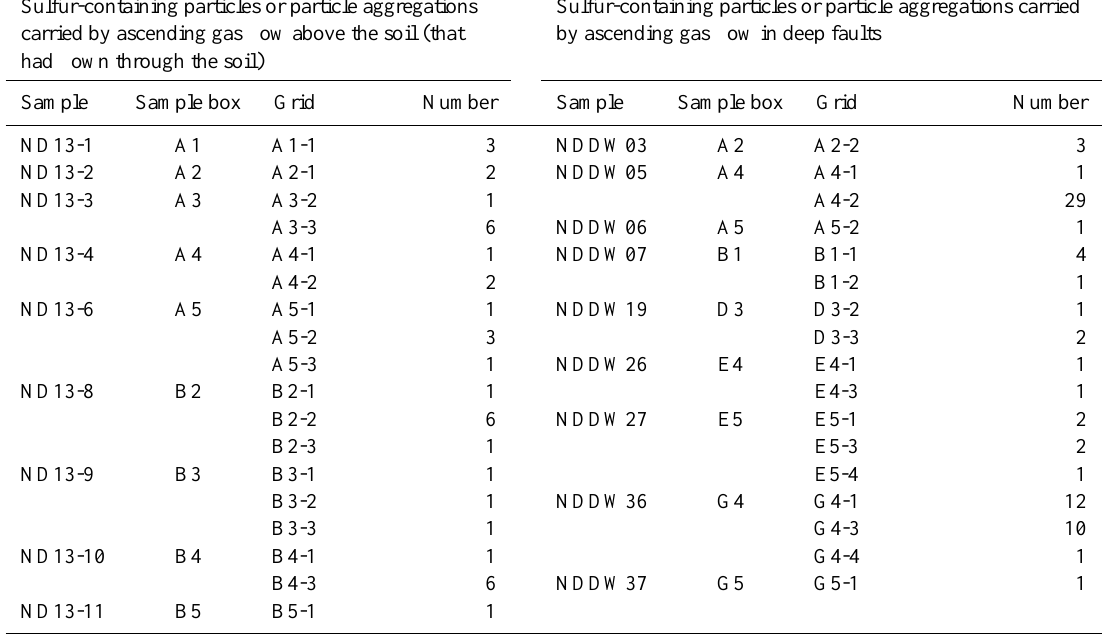
Sulfur-containing particles or particle aggregations carried by ascending gas flow in deep faults